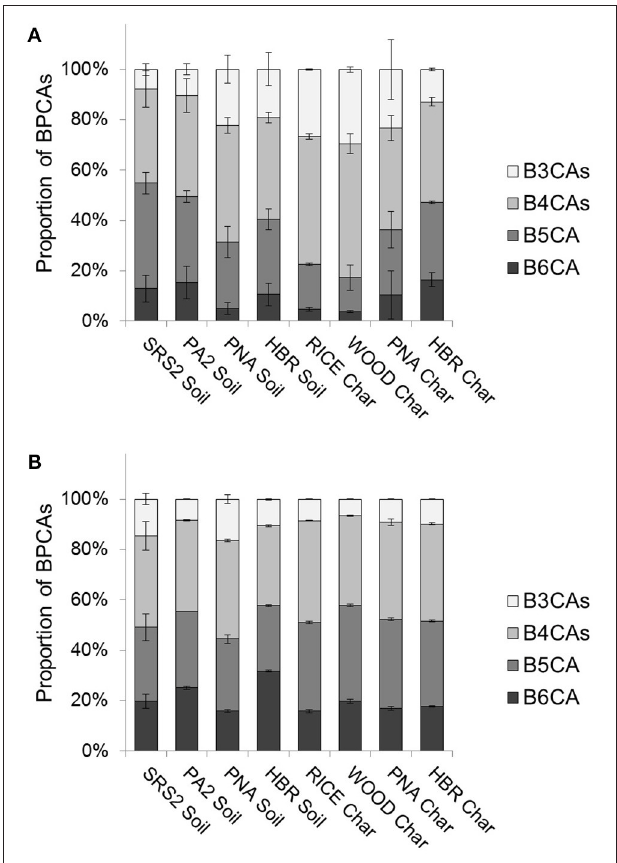
FIGURE 3 | Relative distributions of BPCAs for (A) DBC in water leachates and (B) BC in particulate soils and chars (error bars = 1